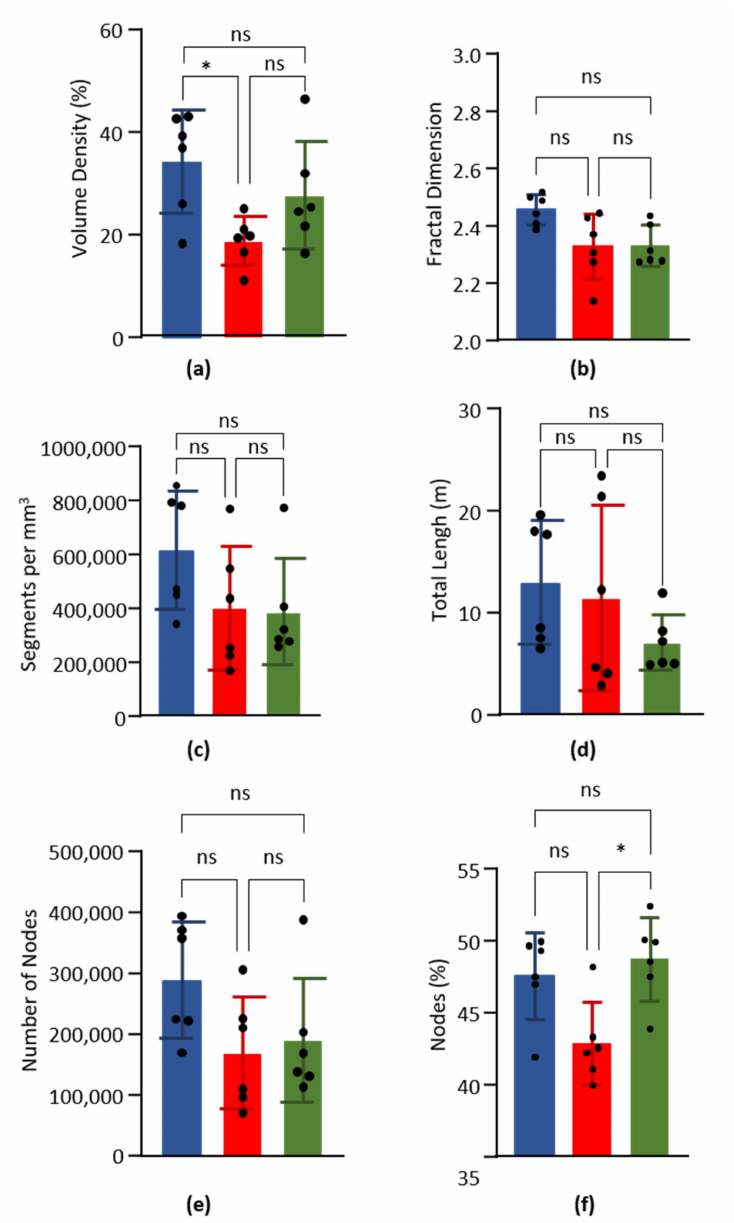
Figure 2. Global parameters. Data obtained from the left ventricle (blue), septum (red) and right ventricle (green) of six hearts. Columns are means and error bars are standard deviations. Black dots are individual values. Data were compared by Kruskal–Wallis test with post-hoc Dunn’s test. ns = non significant. * p < 0.05. ( a ). Volume capillary density, in %. ( b ). Fractal dimension. ( c ). Number of capillary segments per mm 3 of cardiac tissue. ( d ). Total length of capillary segments (m) per mm 3 of cardiac tissue. ( e ). Number of nodes per mm 3 of cardiac tissue. ( f ). Percentage of nodes on the number of